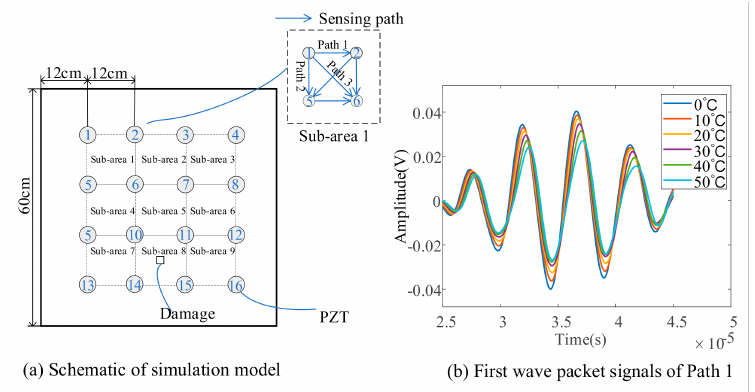
Figure 4. Simulation model and signals of Path 1 (PZT 1–PZT 2).